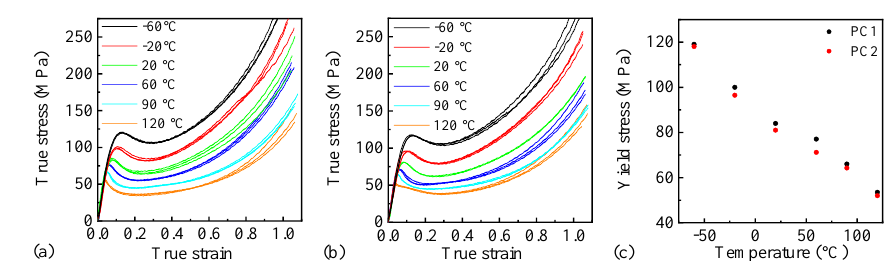
Fig. 2. (a) PC1 stress-strain curve at 0.01 s -1 and varying temperatures, (b) PC2 stress-strain curve at 0.01 s -1 and varying temperatures, (c) Temperature-dependent yield stress comparing between PC1 and PC2.